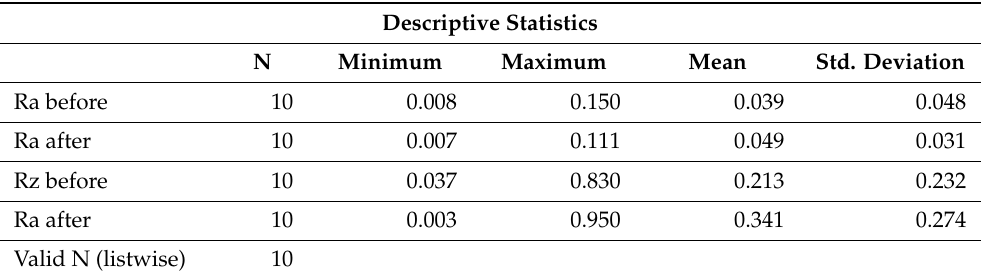
Table 1. Descriptive Statistics for samples scanned on an area of X Scan size 10 μ m on Y Scan size 10 μ m before fluoridation and after fluoridation. The values are presented in micrometers.